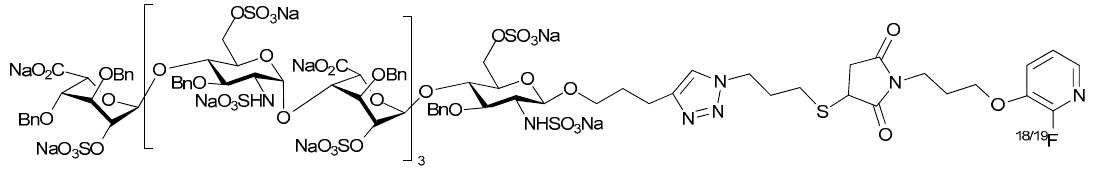
Figure 8. Chemical structure of the conjugated and radiolabeled octasaccharide-based HS